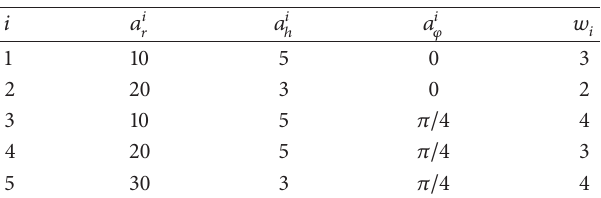
Table 1: Initial data.